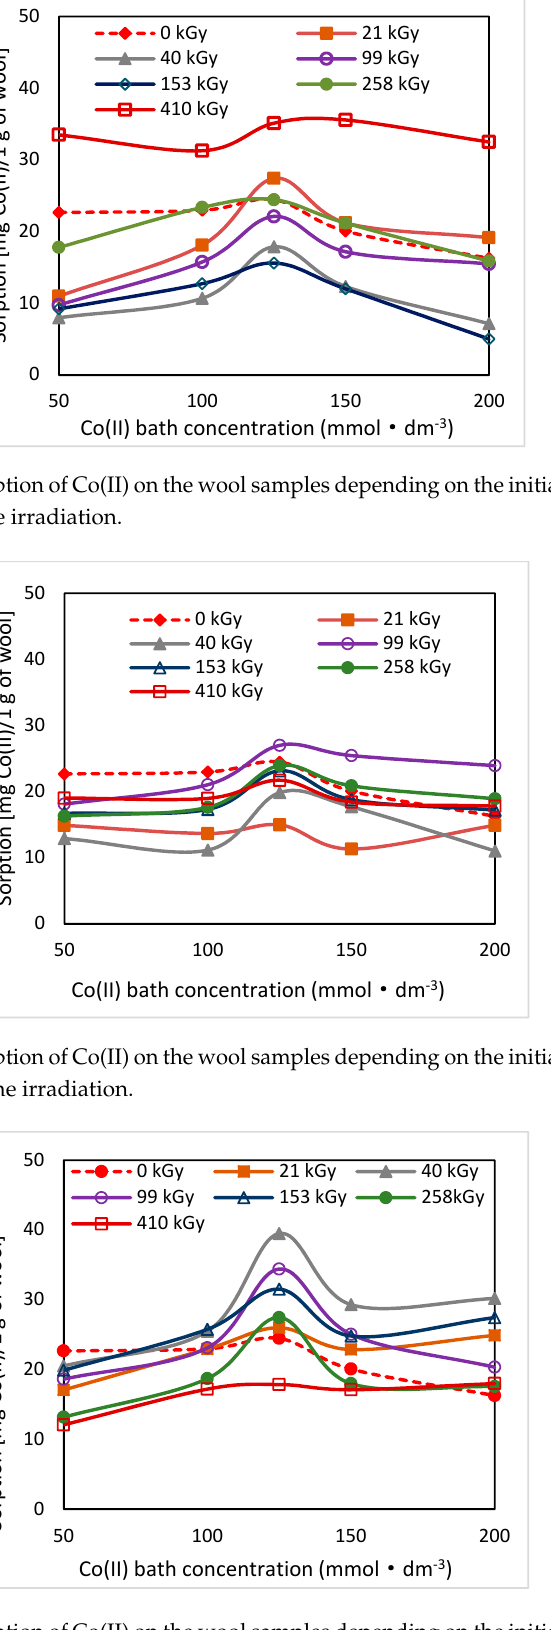
Figure 3. Variation of sorption of Co(II) on the wool samples depending on the initial bath concentration measured 100 days after the